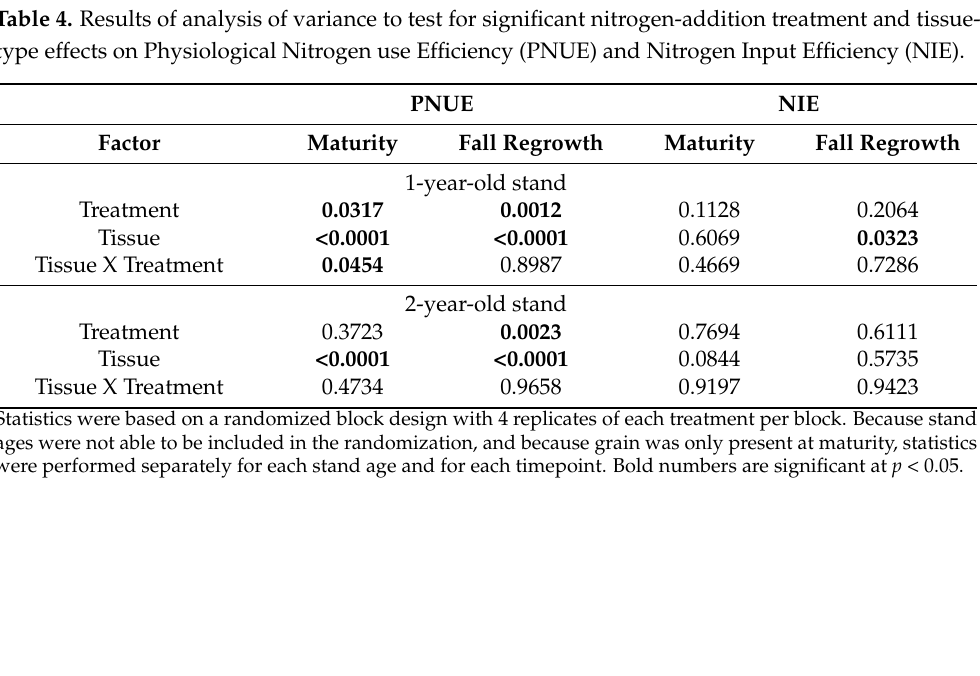
Figure 3. PNUE and NIE by tissue type and sample timing in 1-year-old and 2-year-old IWG stands. Within each stand age, bars with the same or no letter are statistically similar as per Tukey’s HSD ( p = 0.05).